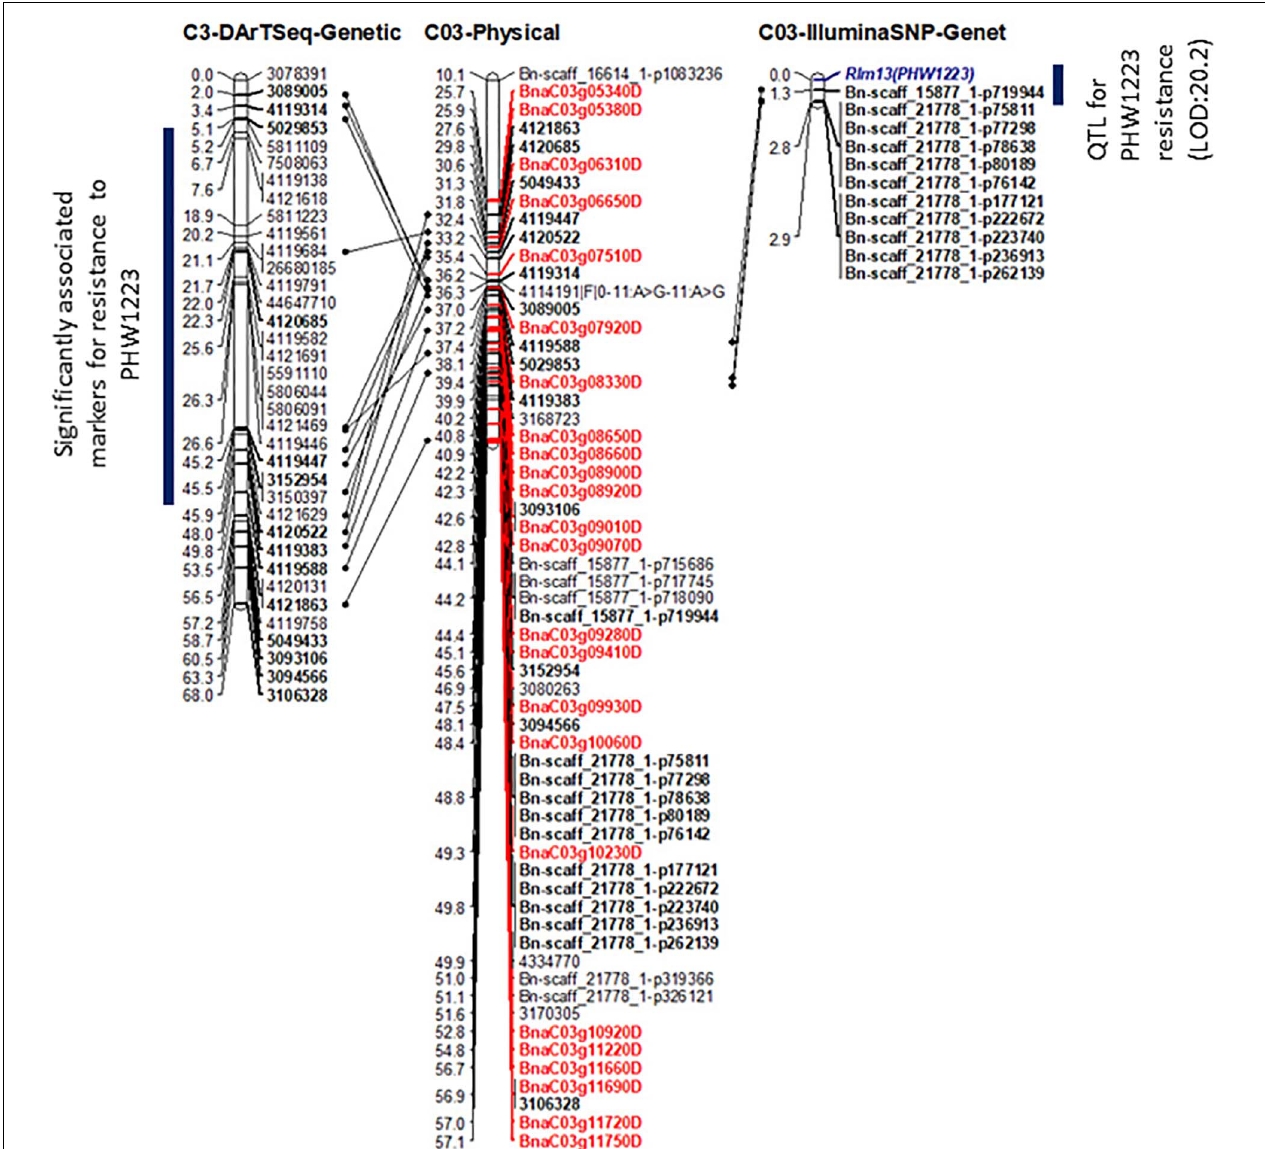
FIGURE 4 | Genetic and physical mapping of the Rlm13 locus in relation to DArTseq and Illumina SNP-based markers. The order of markers was determined using the Record program. The marker order is shown on the right-hand side , while the genetic and physical positions of markers and candidate genes (labeled in Red color) are on the left-hand side . Positions of common markers across genetic and physical maps are in bold. For clarity, physical distances are given in 0.1